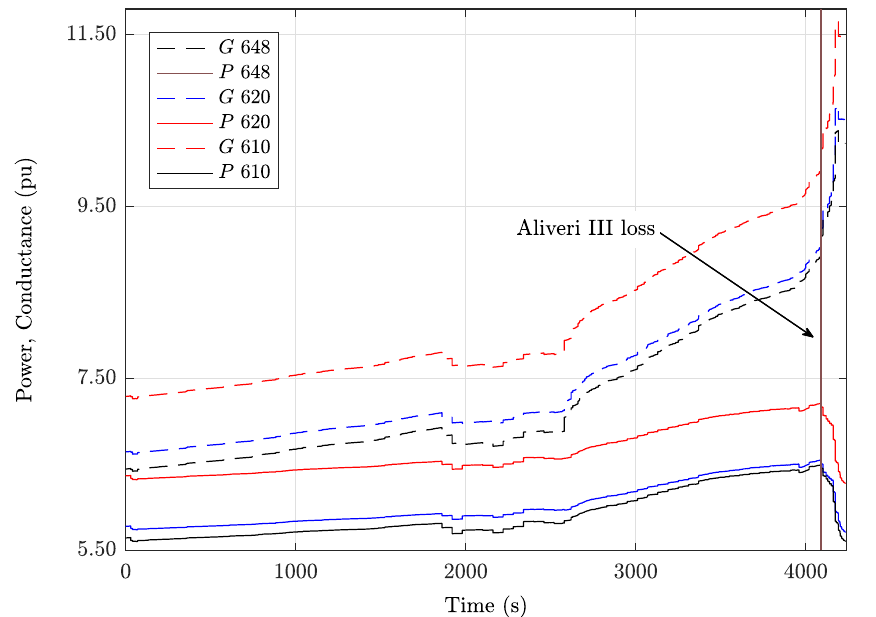
Figure 9. Active power transfer and apparent conductance at EHV buses 610 (Acharnon), 620 (Koumoundourou) and 648 (Ag. Stefanos), unstable